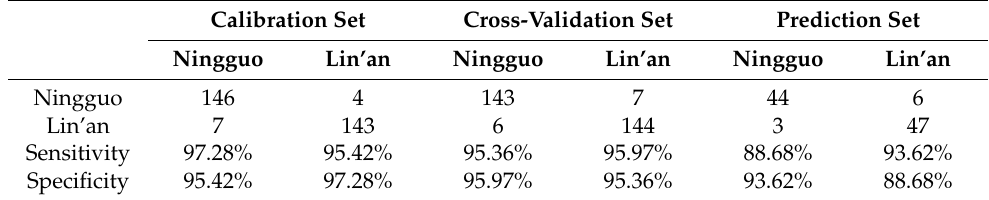
Table 4. Confusion matrix in the three sets predicted using the optimal simplified